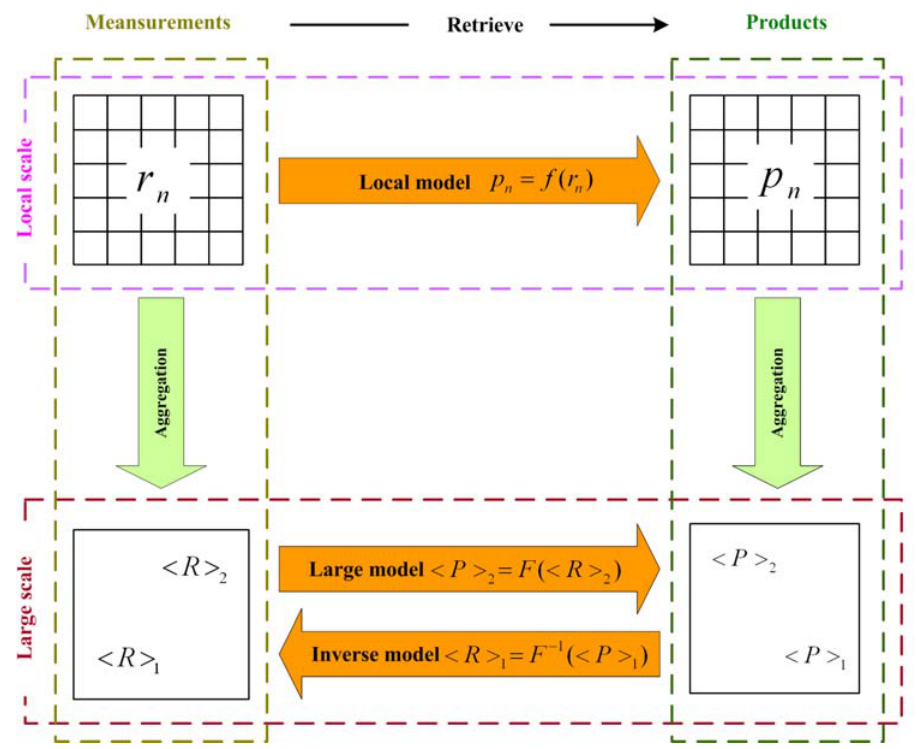
Figure 1. The relationship of measurements, retrieval model and products at different